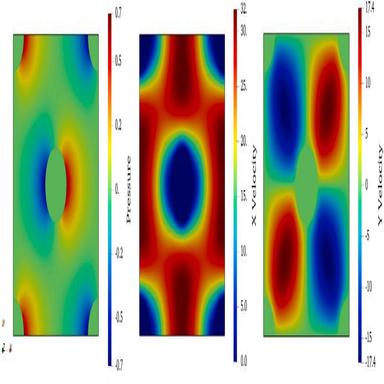
Pressure (left) and velocity (right) fields for the 50002 image for a simulation in direction.